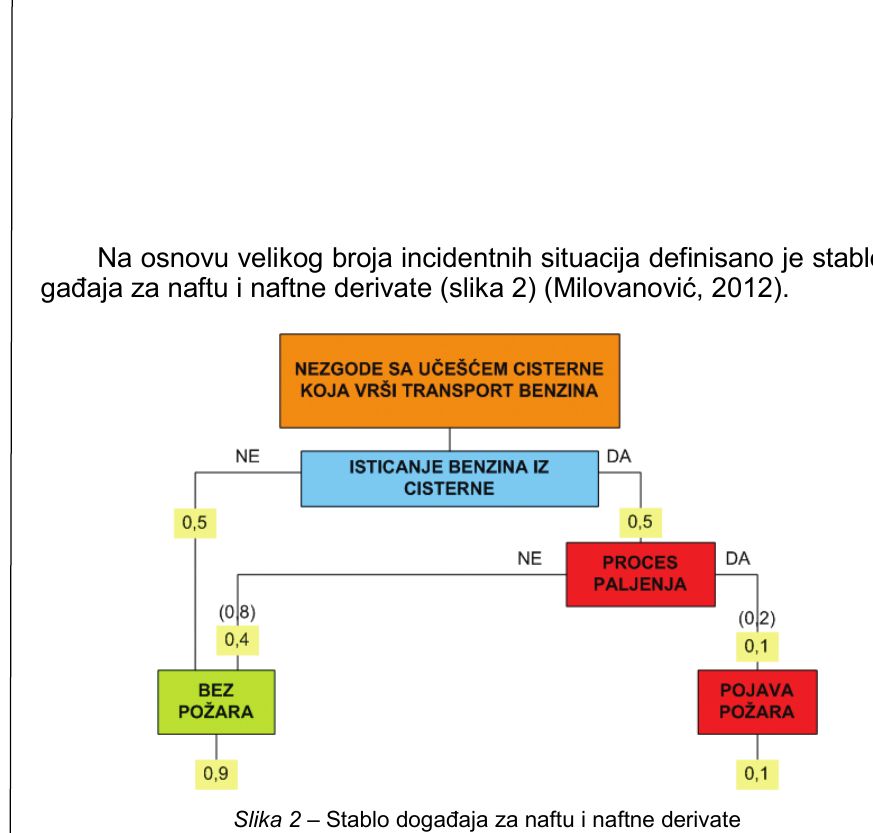
Figure 2 – Event tree for oil and petroleum